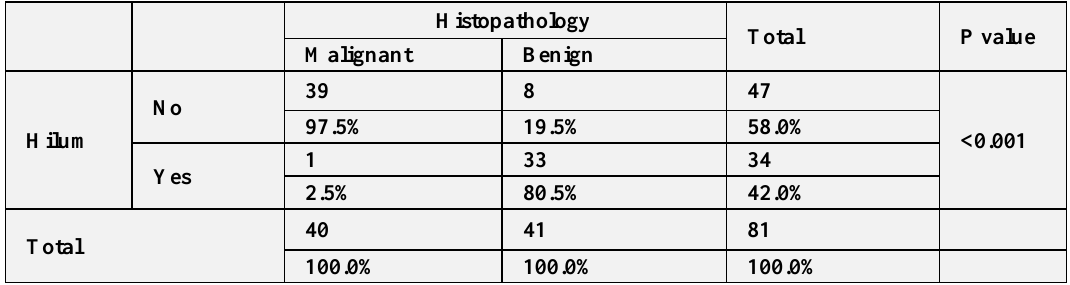
Table (11):- Association between histopathological findings and hilum of L.N